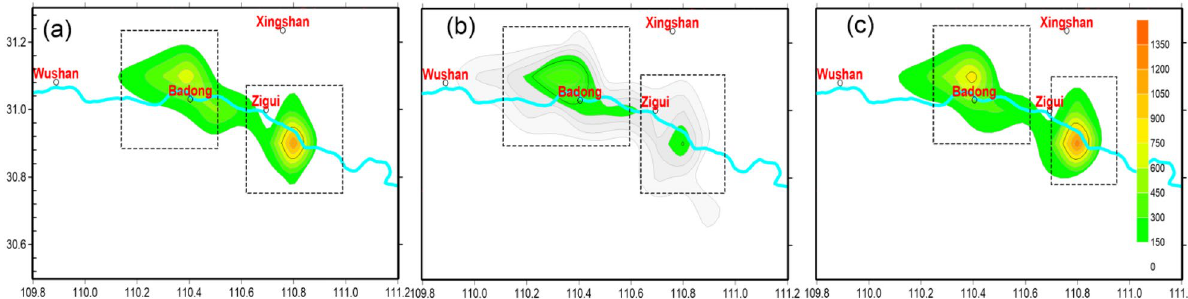
Figure 4. Contour map of the number of events per month from September 2008 to April 2020 during different time periods. ( a ) From January to May, ( b ) from June to August, ( c ) from September to